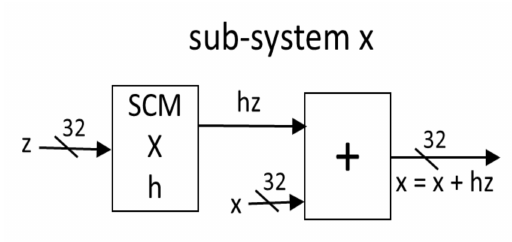
Figure 17. Realization of the sub-system X on